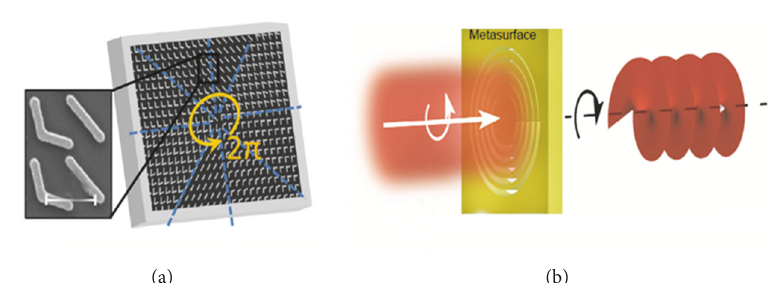
Figure 6: (a) Eight groups of V-shaped focusing structures arranged in the radial direction of the circle, arranged along the azimuth direction with 0, 𝜋 /4, 𝜋 /2, 3 𝜋 /4, 𝜋 , 5 𝜋 /4, 3 𝜋 /2, and 7 𝜋 /4 phase antennas and linear spacing 𝜋 /4. (b) Vortex phase mode.